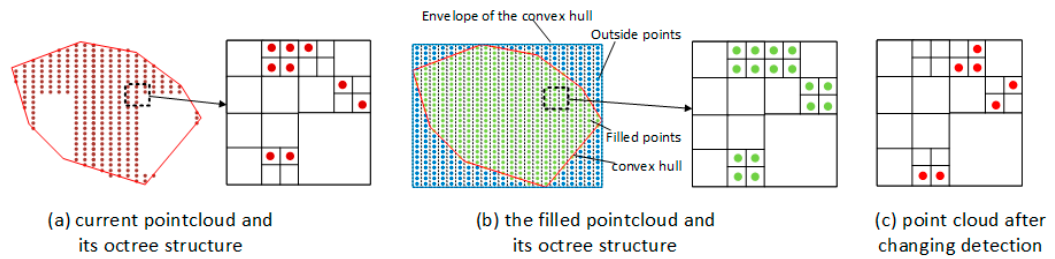
Figure 9. Point filling and changing detection methods.